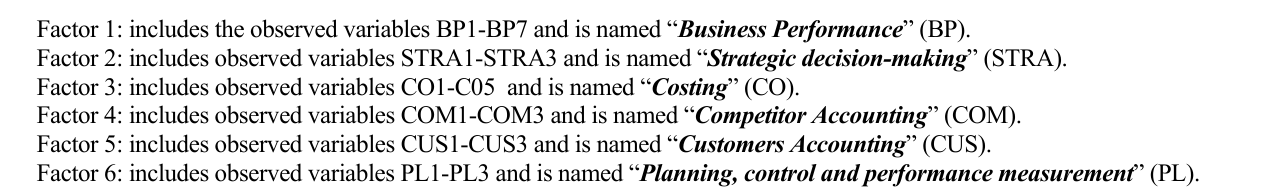
The results of KMO and Bartlett’s test Kaiser-Meyer-Olkin Measure of Sampling Adequacy. Bartlett's Test of Sphericity